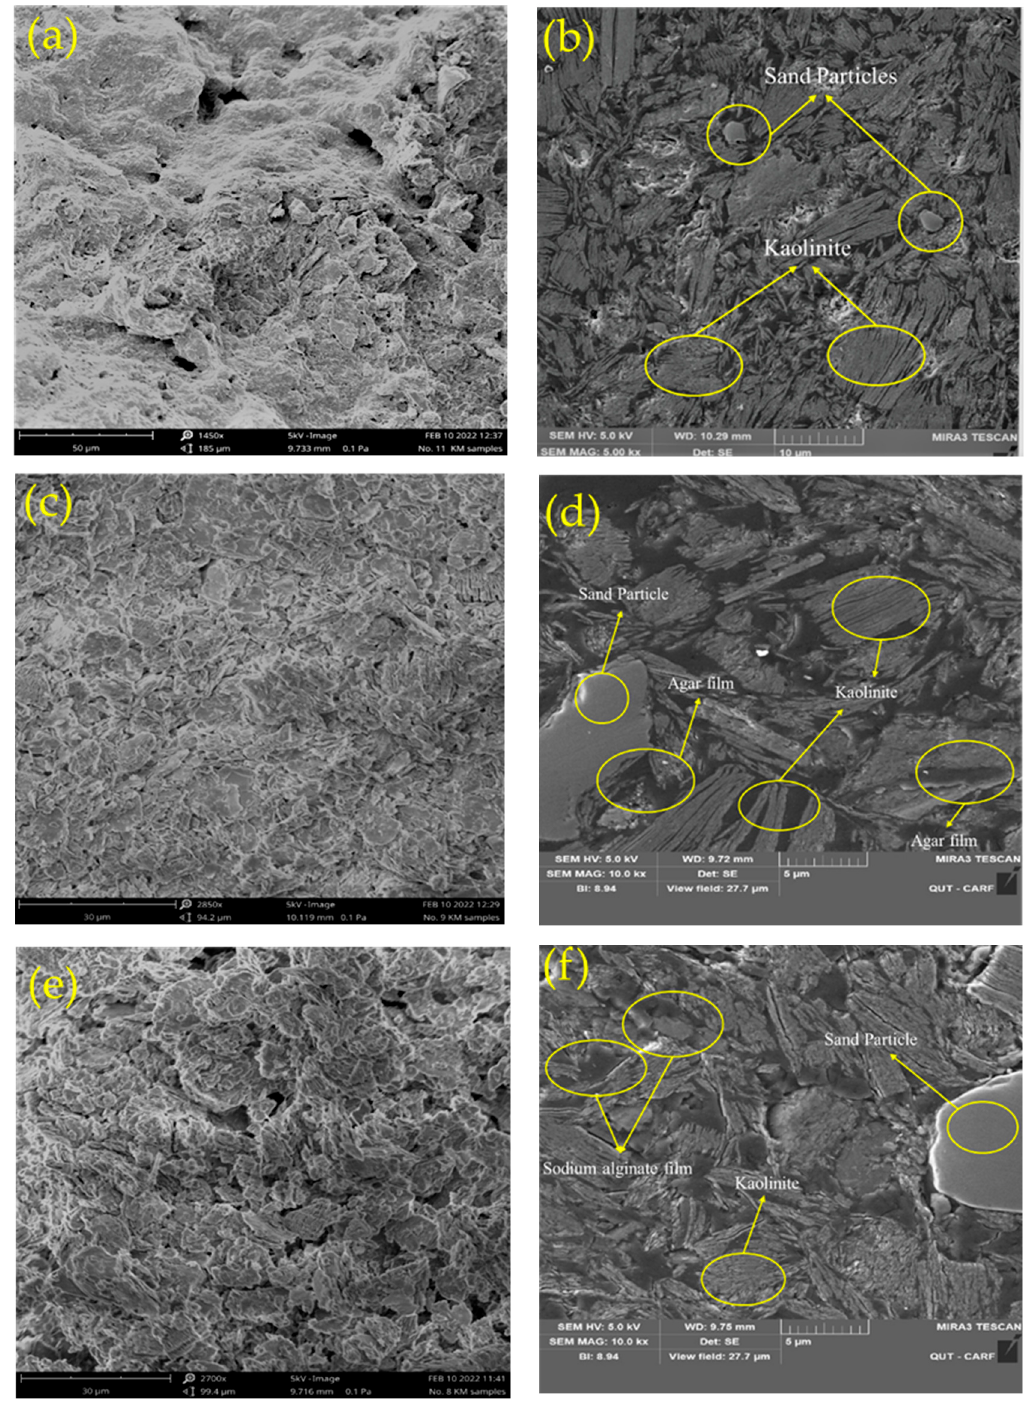
Figure 9. SEM images of ( a ) Kaolinite, ( b ) K1S3, ( c ) K4S0-Ag, ( d ) K1S3-Ag, ( e ) K4S0-SA, ( f ) K1S3-